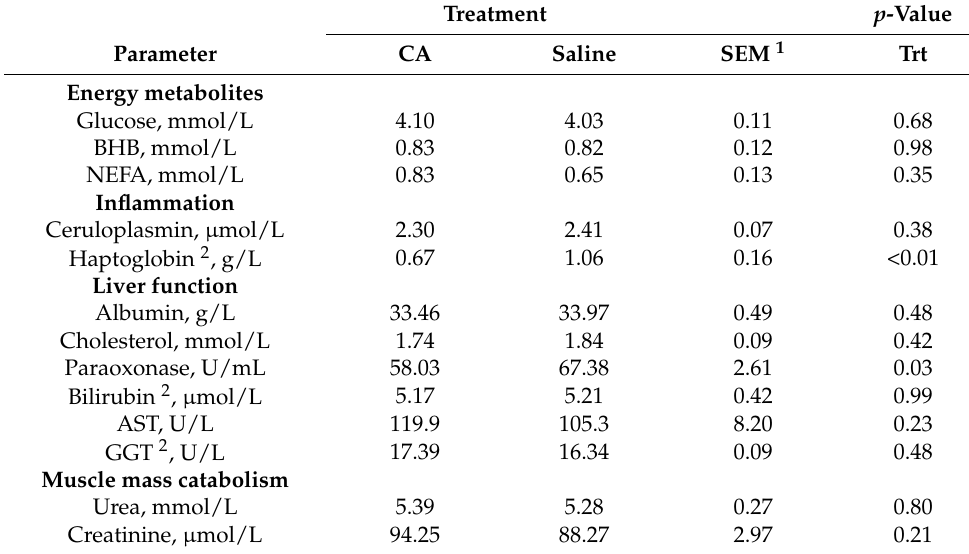
Table 5. Effects of intravenous infusion of carnosic acid (CA) or saline solution (Saline) on blood biomarkers related to energy metabolism, inflammation, liver function, muscle body mass, metabolism, and oxidative stress in dairy cows at 2 d relative to